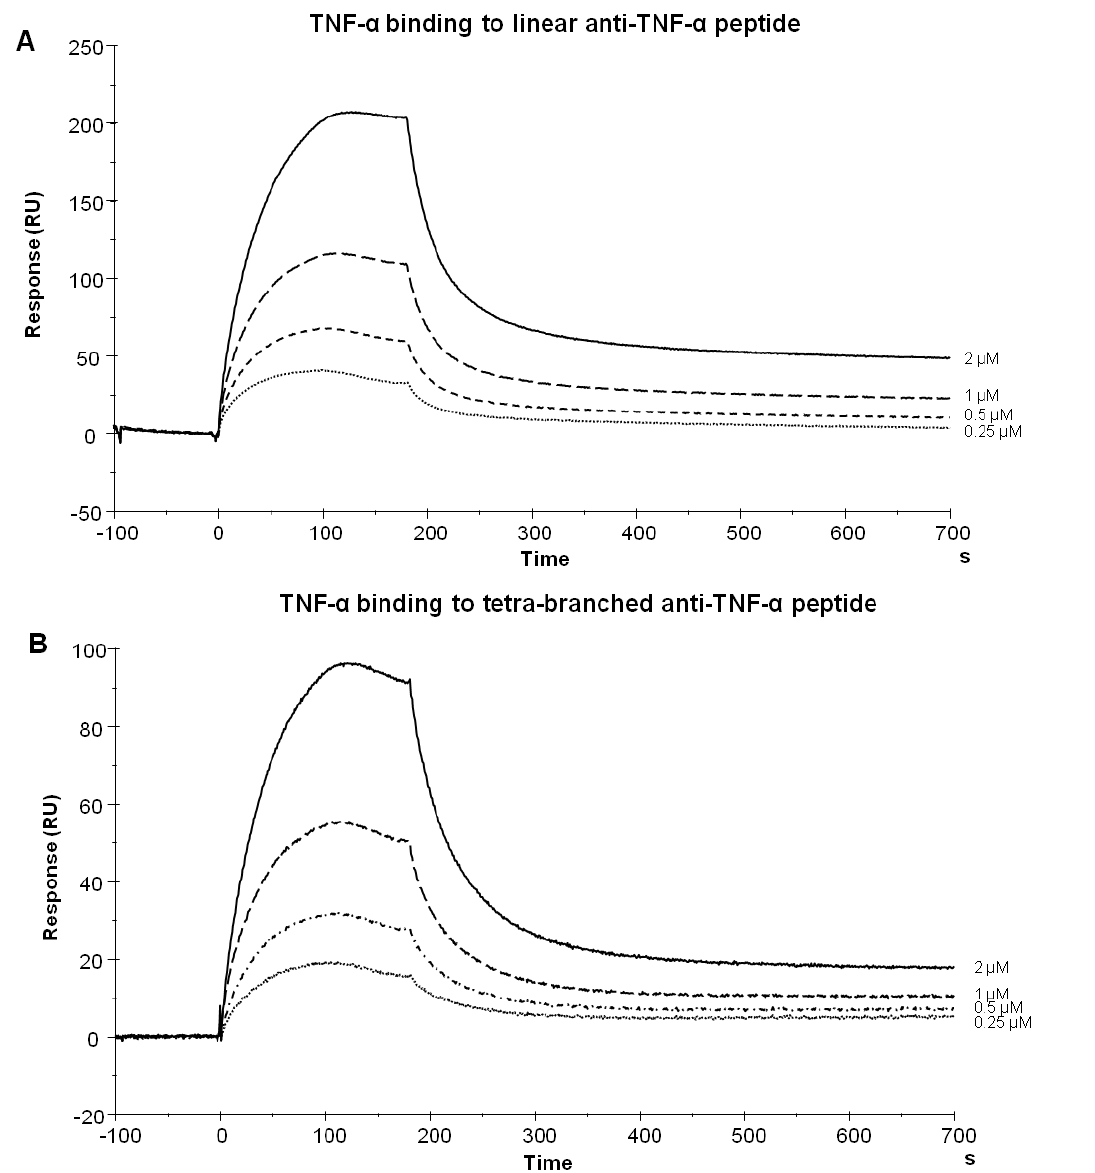
Figure 2. Biacore sensorgrams illustrating hTNF- α binding to the immobilized peptides. TNF- α , from 250 nM to 2 µM, was injected over biotin-coupled linear (A) or tetra-branched (B) peptide immobilized on a SA sensor